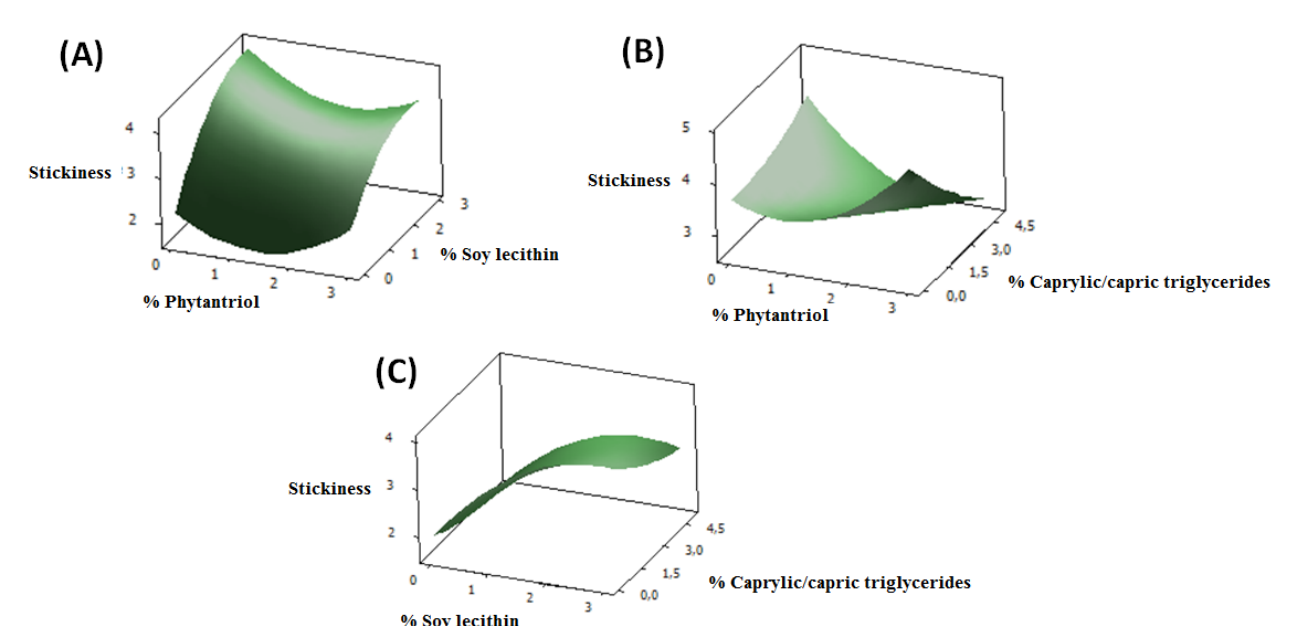
FIGURE 7 - Response surfaces for stickiness (P), as a function of the factors: % phytantriol and % of soy lecithin.